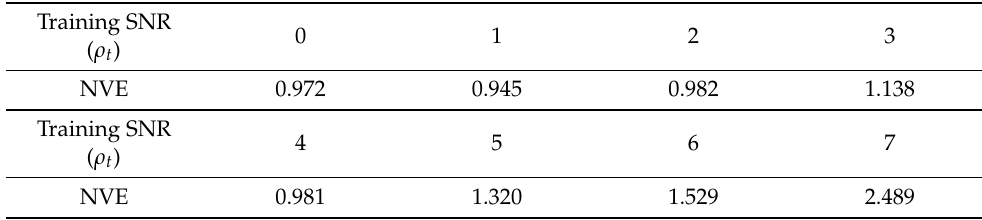
Table 4. NVE for different training SNRs.